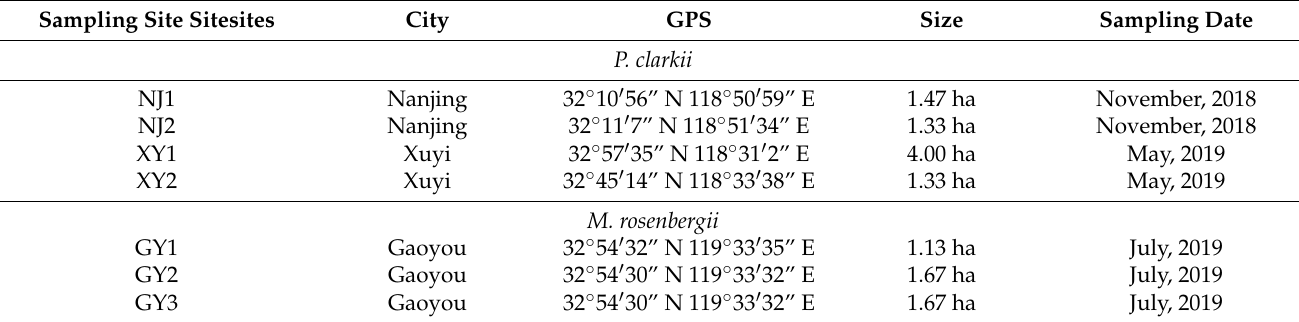
Table 1. Information about the sampling